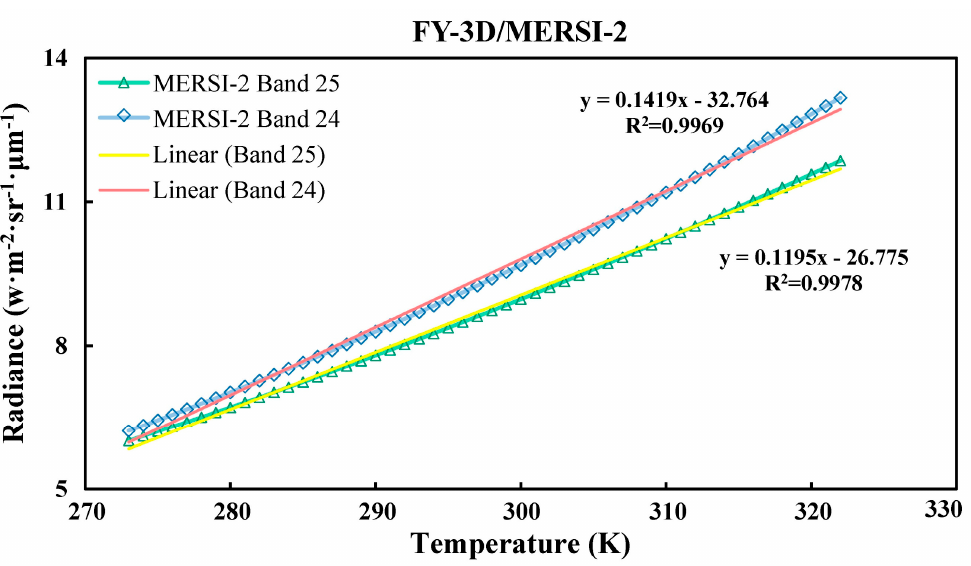
Figure 3. The relationship between radiation intensity and temperature for MERSI-2 B24 and